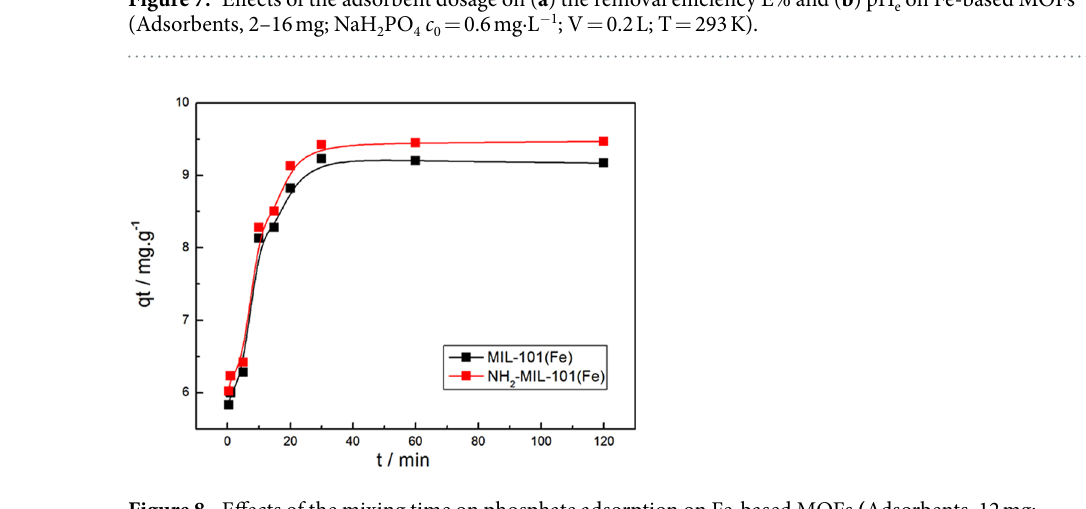
Figure 8. Effects of the mixing time on phosphate adsorption on Fe-based MOFs ( Adsorbents, 12 mg;